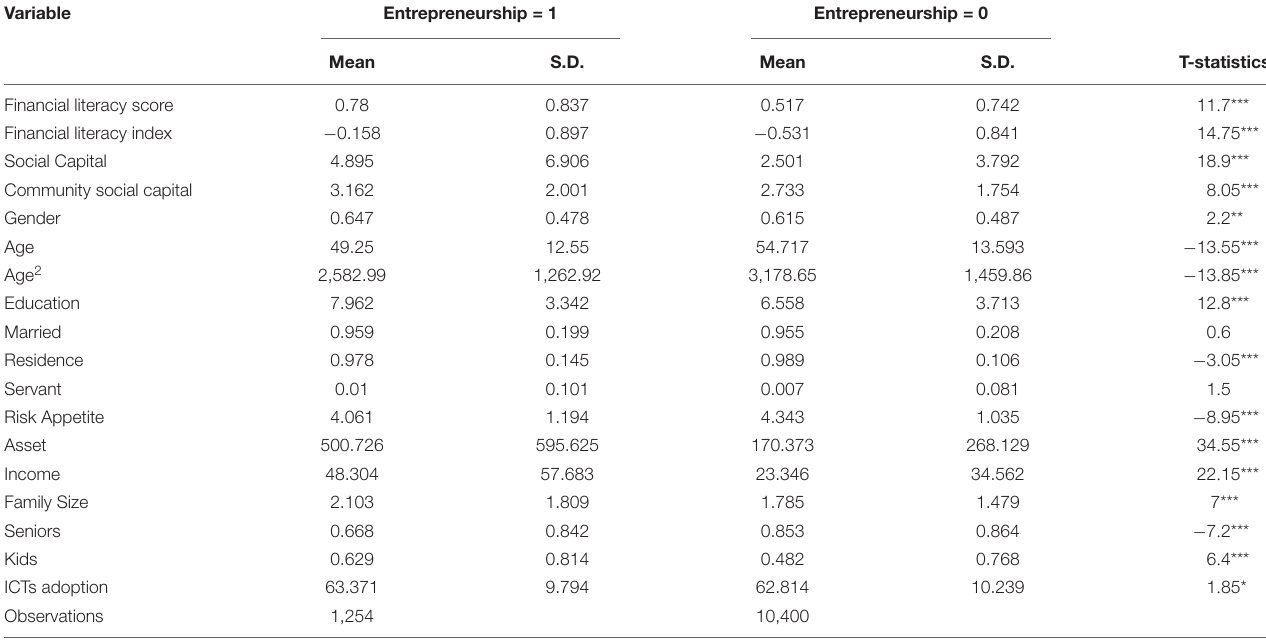
TABLE 6 | Comparison of the variables between different groups.